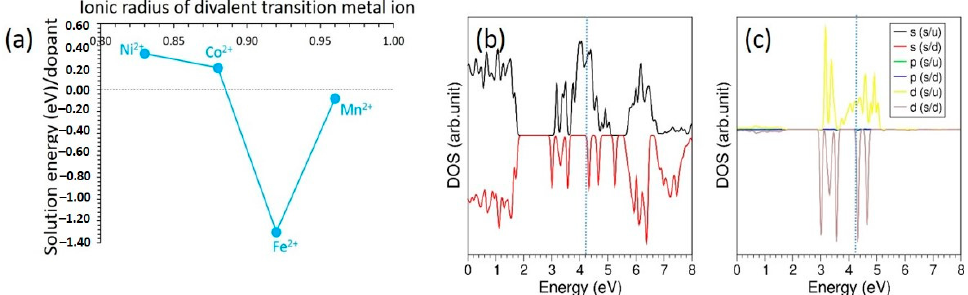
Figure 5. ( a ) Energies of solution calculated for transition metal dopants on the Zn site, ( b ) total DOS plot of Fe-substituted Zn 3 V 4 (PO 4 ) 6 , and ( c ) DOS plot associated with the Fe.